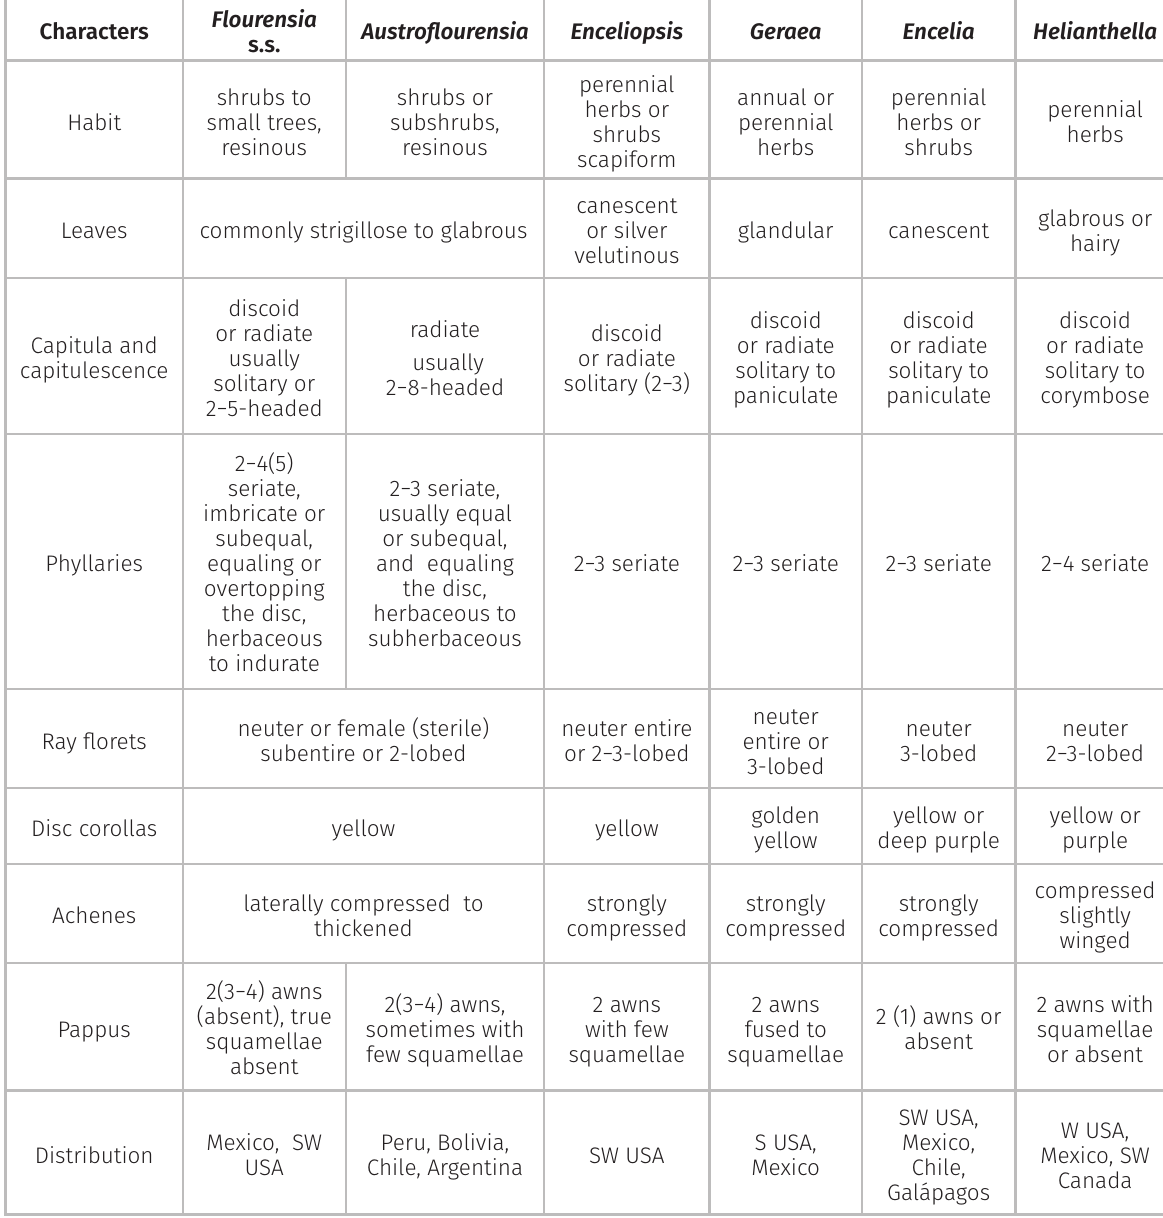
Table II. Diagnostic characters of the two lineages of Flourensia s.l. and the remaining genera of the subtribe